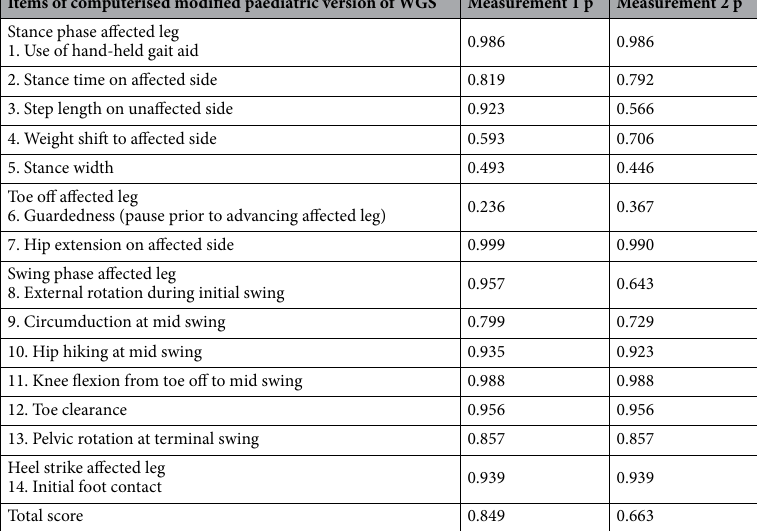
Items of computerised modified paediatric version of